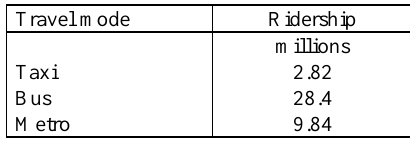
Table 1. Summary of daily public ridership in Shenzhen, China